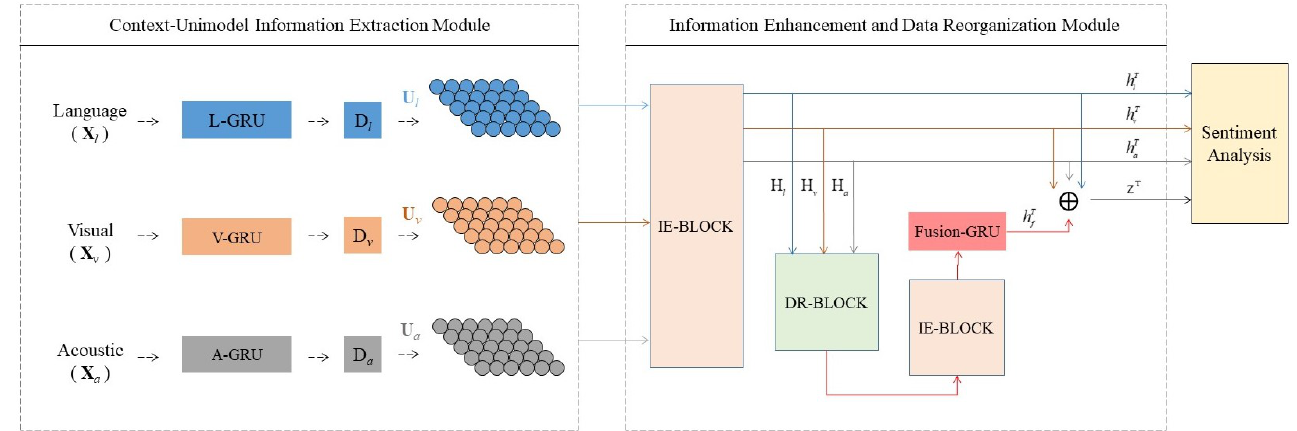
Figure 1. The overall architecture of the Multimodal Sequence Feature Extraction Network (MSFE). It consists of three modules: (1) Context-Unimodal Information Extraction Module is composed of three sub-networks containing GRU network, which are used to process contextual information in language, visual, and audio modalities. (2) Information Enhancement and Data Reorganization Module can be divided into information enhancement (IE) block, data reorganization (DR) block, and GRU network. (3) Sentiment Analysis Layer includes sentiment prediction and sentiment